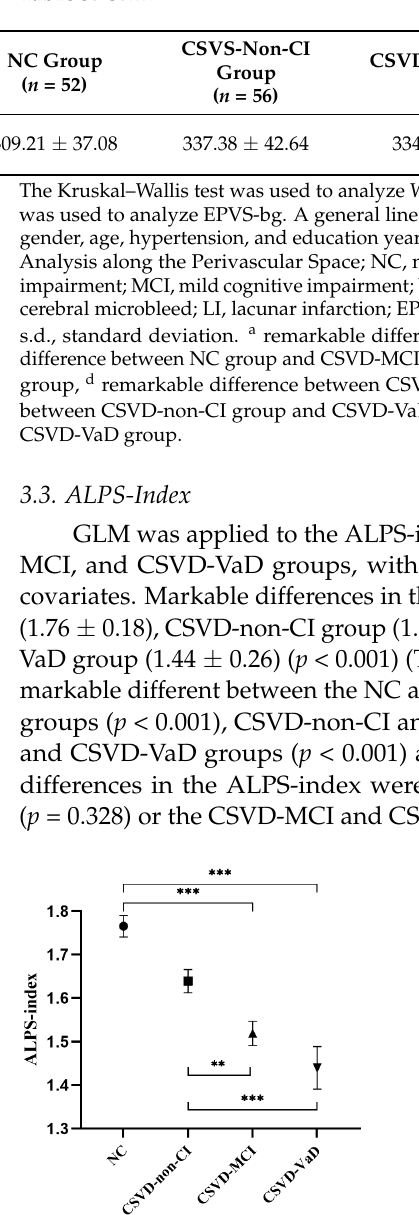
Figure 3. Comparison of the ALPS ‐ index in the NC, CSVD ‐ non ‐ CI, CSVD ‐ MCI, and CSVD ‐ VaD groups. Abbreviations: ALPS ‐ index, the index of Diffusion Tensor Image Analysis along the Peri ‐ vascular Space; NC, normal control; CSVD, cerebral small vessel disease; CI, cognitive impairment; MCI, mild cognitive impairment; VaD, vascular dementia. Values are presented as mean and stand ‐ ard error of mean. ● : Mean ALPS ‐ index in the NC group, ■ : Mean ALPS ‐ index in the CSVD ‐ non ‐ CI